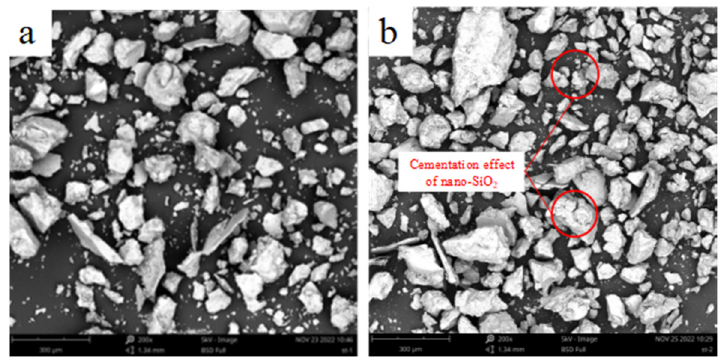
Figure 13. SEM micrographs of the ( a ) sandy soil; ( b ) 2% nano-SiO 2 -reinforced sandy soil.